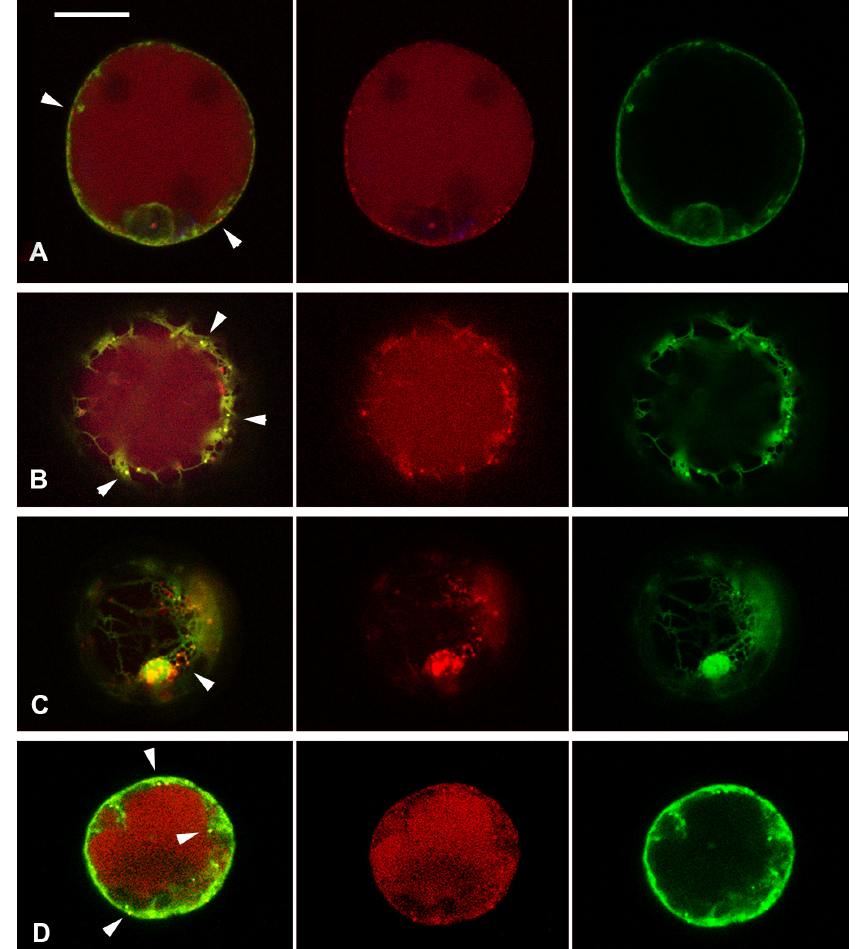
Figure 4. Tomato hypocotyl protoplasts transiently co-transformed with GFPChi (in green colour) and AleuRFP (in red colour). ( A ) Cell in control conditions, GFPChi is restricted to the ER and only AleuRFP labels small punctate structures (white arrows); ( B ) Cell treated with Auxin, it induces concentration of GFPChi in small punctate structures that colocalized partially with those labeled by AleuRFP (white arrows); ( C ) Cell treated with ACh, it caused accumulation of GFPChi in small vacuoles surrounded by several AleuRFP labeled structures (white arrow); ( D ) Cell treated with the two chemical combined, the treatment appeared very stressful but again it was evident that GFPChi and AleuRFP colocalized in punctate structures (white arrows); and ( E ) Cell treated with BFA induced bodies where GFPChi and AleuRFP colocalized partially (white arrows) but colocalization was not observed in the small discrete compartments exclusively labeled by AleuRFP. Scale bar: 20 μ